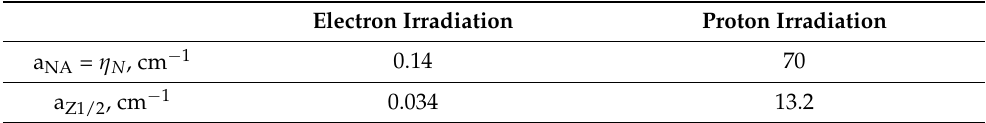
Table 1. Generation rates of deep